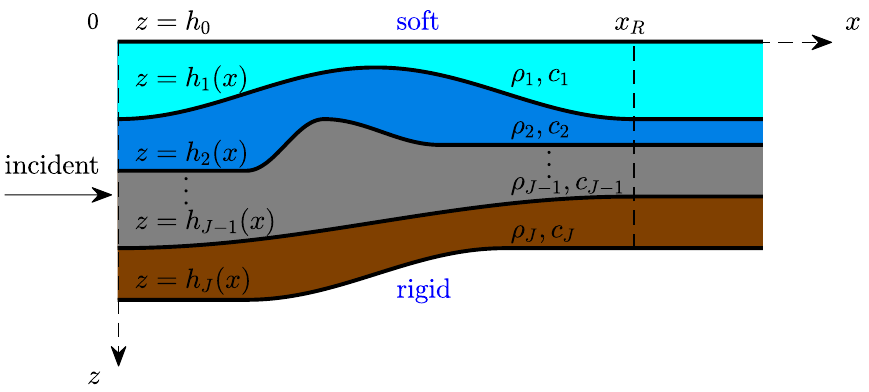
Figure 1. (Color online) Geometry of 2D multilayered